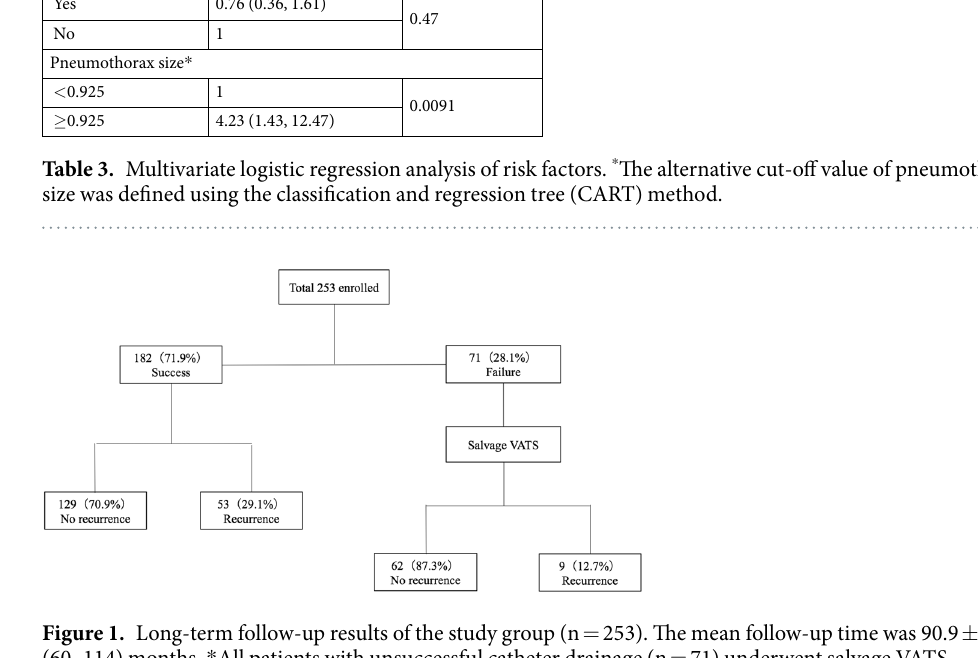
Figure 1. Long-term follow-up results of the study group (n = 253). The mean follow-up time was 90.9 ± 14.6 (60–114) months. * All patients with unsuccessful catheter drainage (n = 71) underwent salvage VATS bullectomy and mechanical